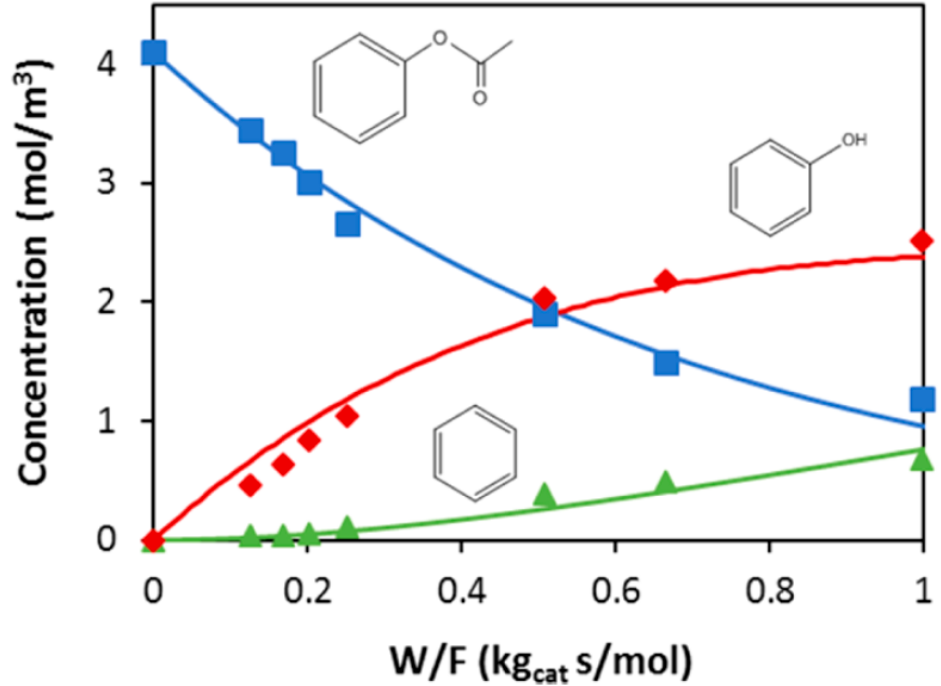
Figure 4. Results from kinetic results of the gas-phase HDO of phenyl acetate over Pt/Al 2 O 3 catalyst at 325 °C under 5 bar with H 2 /O ratio of 23 [61].